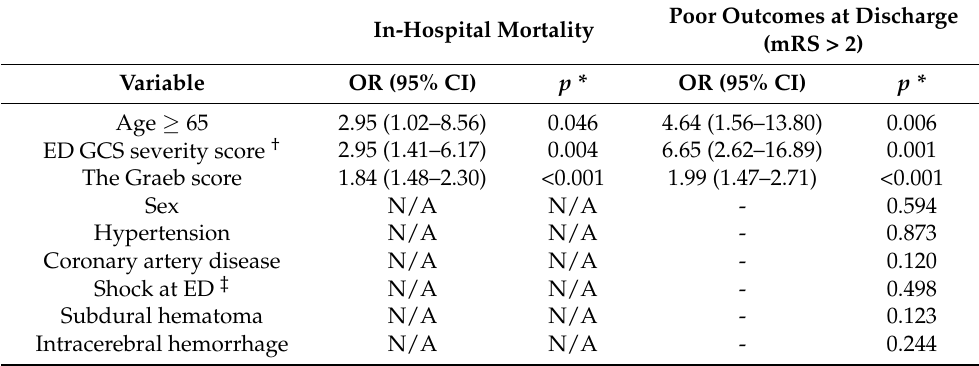
Table 4. Multivariate analysis for predictors of in-hospital mortality and poor outcomes at discharge in patients with